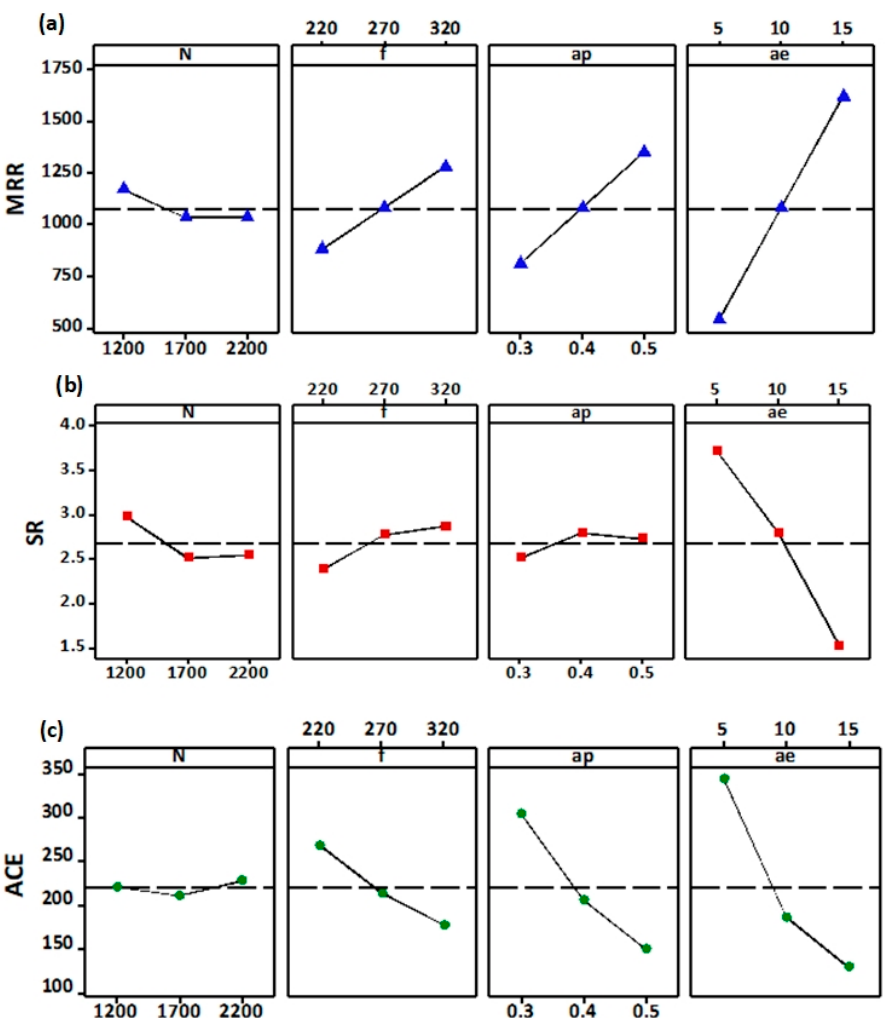
Figure 9. Main effect plots for, ( a ) MRR, ( b ) SR, ( c ) ACE.